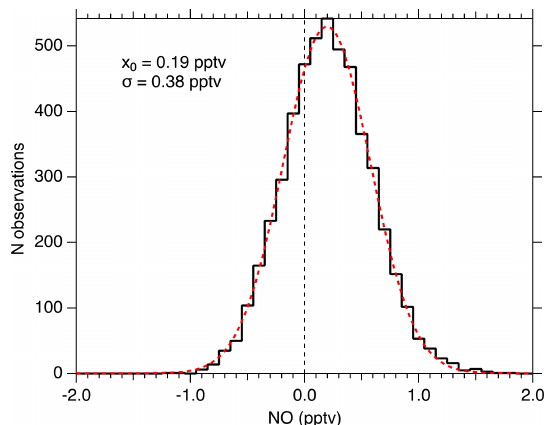
Figure 11. Histogram of observations sampling zero air scrubbed with potassium permanganate.